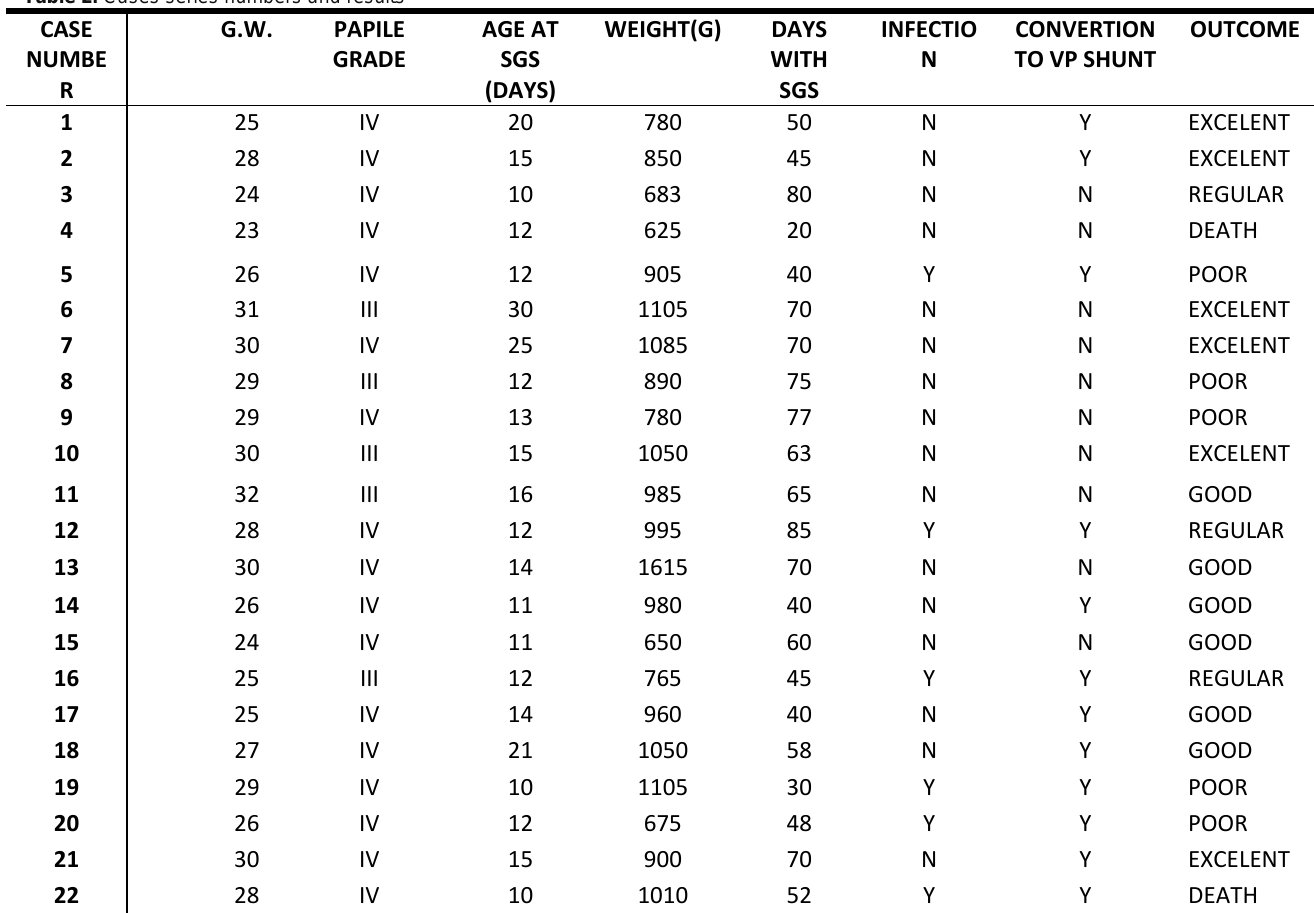
Table 2. Cases series numbers and results